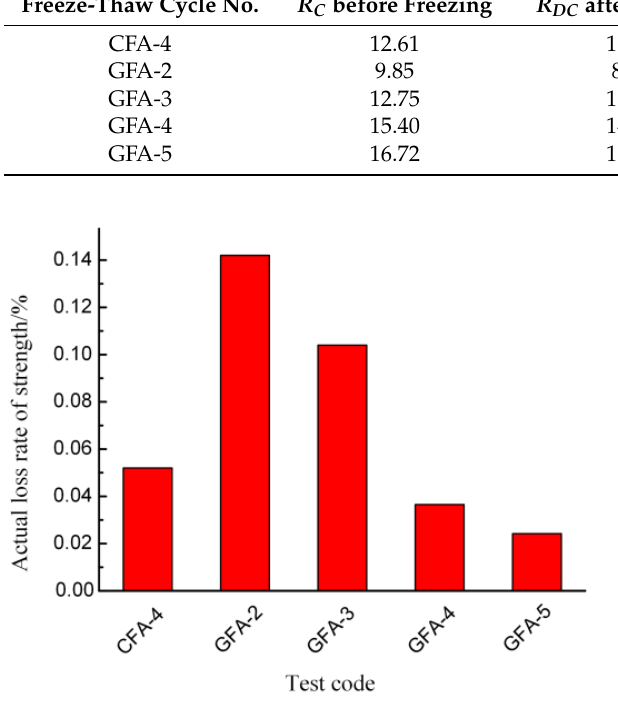
Figure 3. Strength loss of different binder stabilized macadam base materials after freeze-thaw cyclic tests.